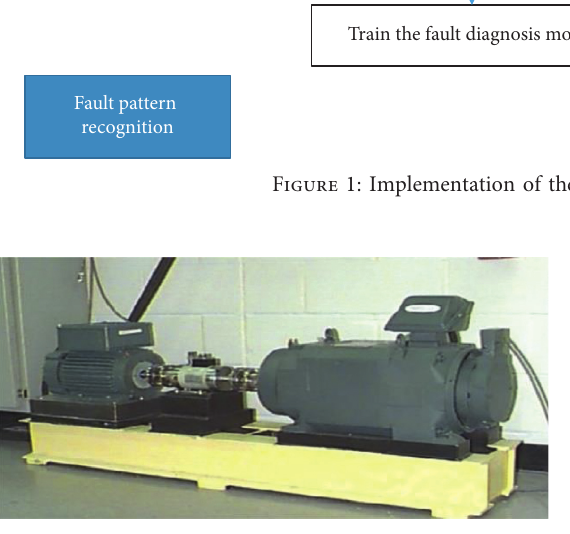
Figure 2: Experimental test rig